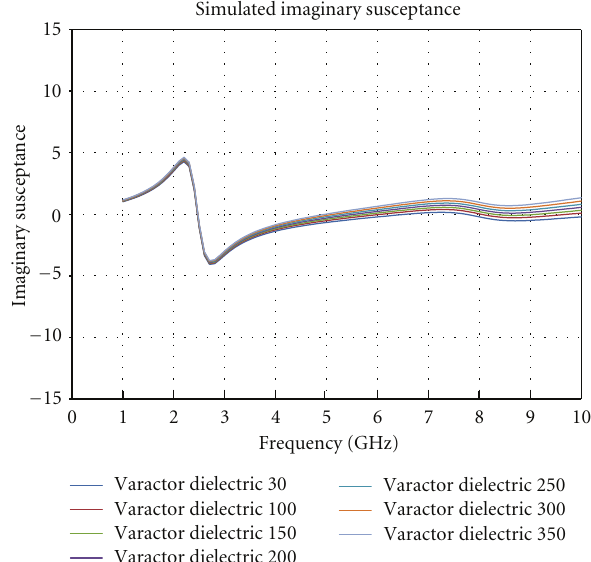
Figure 6: Simulated swept frequency S 11 of the antenna system.